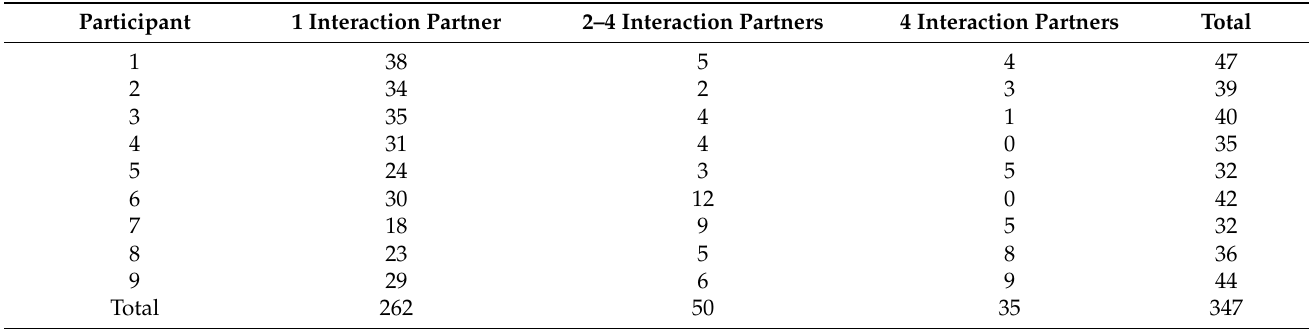
Table 1. Number of interaction partners for each